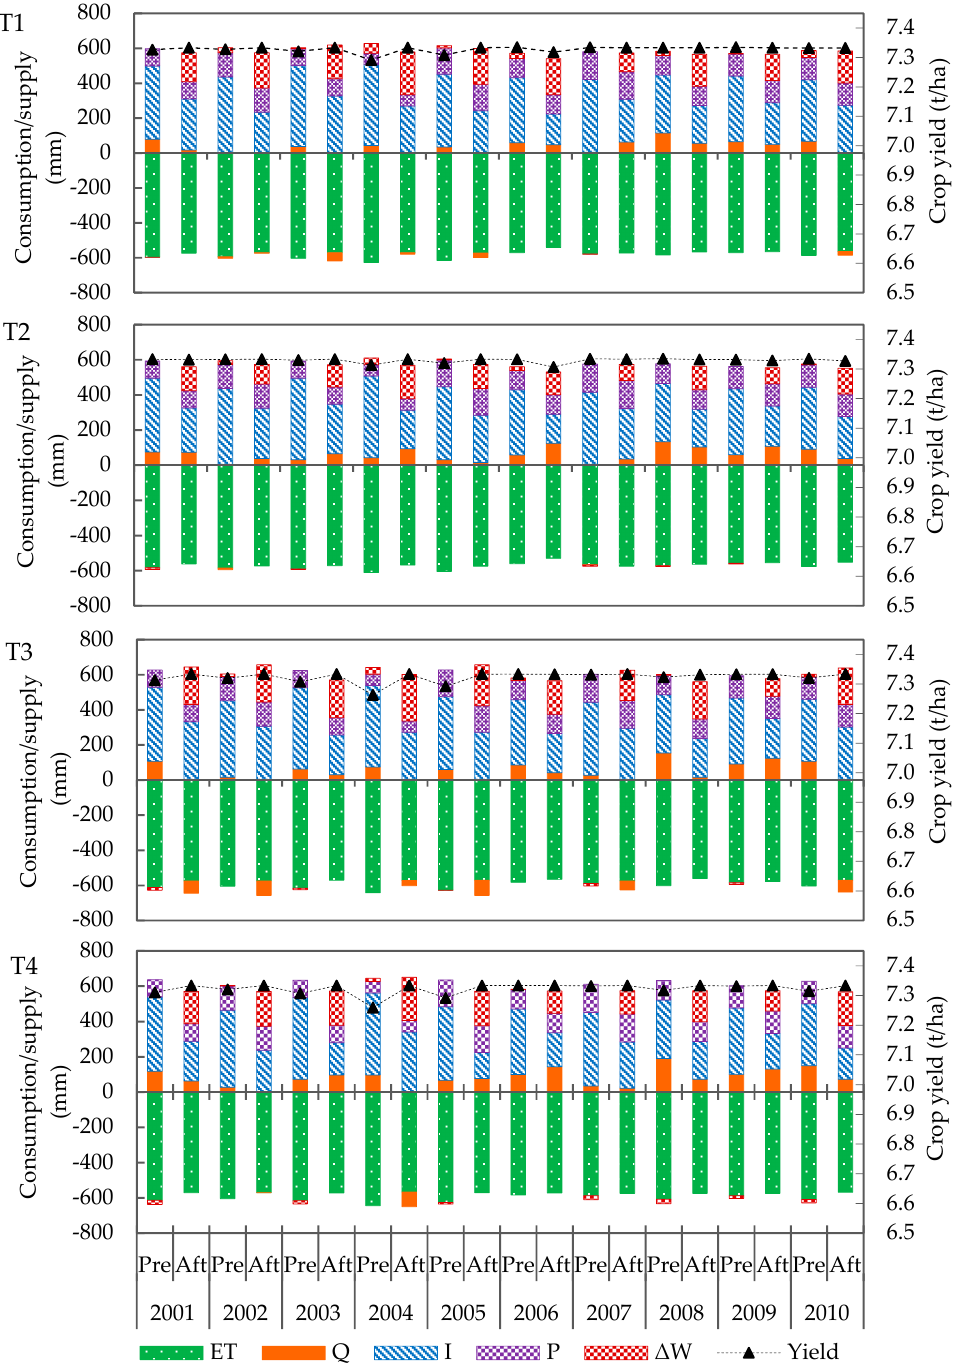
Figure 7. Mean values of soil water consumption and supply (positive means supply, negative means consumption, ET means evapotranspiration, Q means deep percolation, ∆ W means changes of water storage, Pre and Aft mean before and after optimization) during 2001 to 2010.